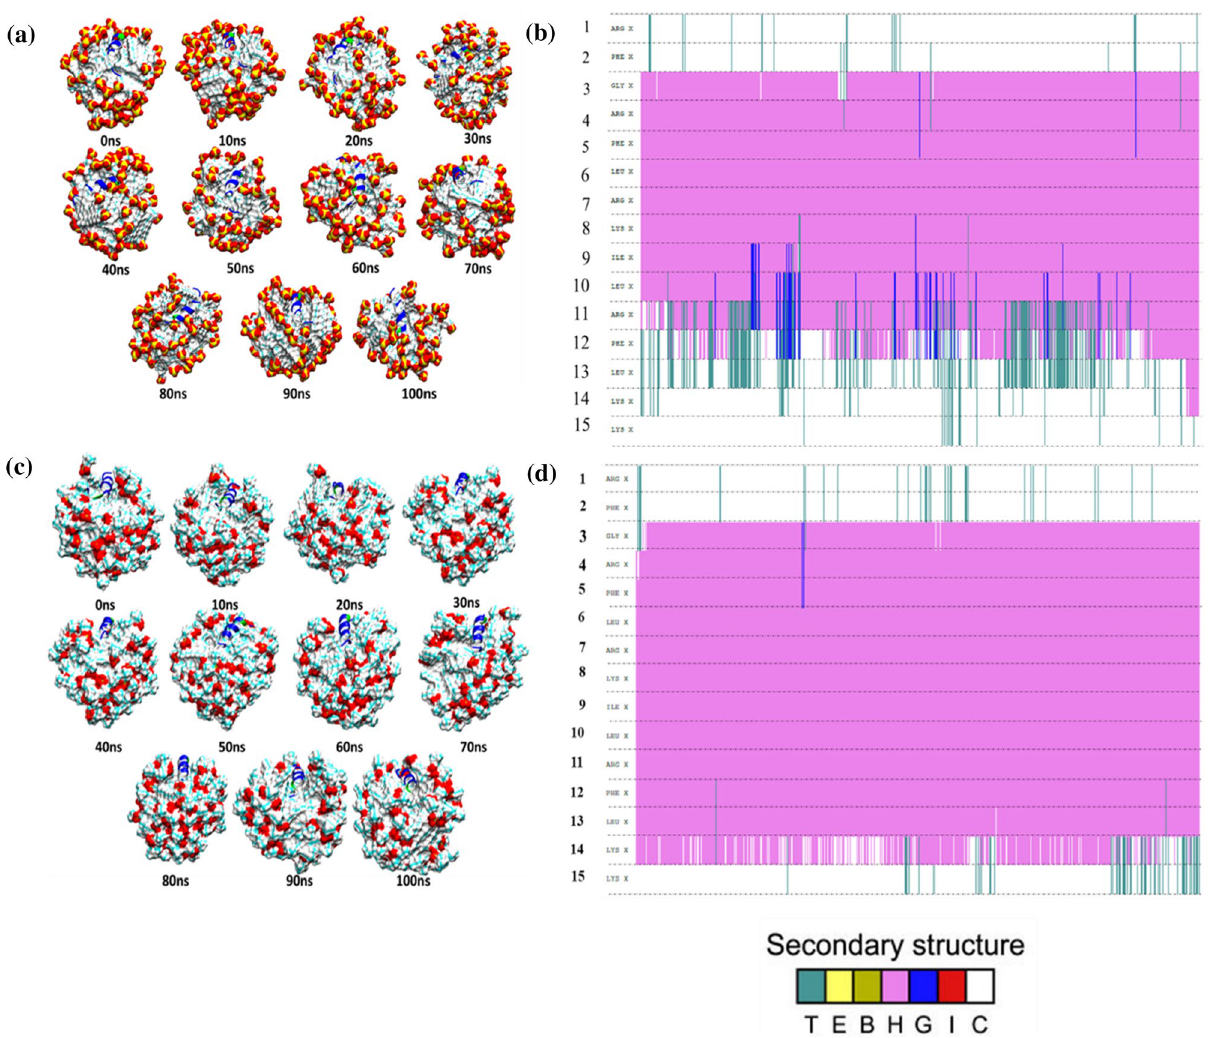
Figure 3. Selected snapshots of the SDS micelle with peptide ( a ) and DPC micelle with peptide complex ( c ). The secondary structure analysis of the peptide in SDS micelle ( b ) and peptide in DPC micelle with water complex ( d ) throughout the 100 ns trajectory. y-axis represents the amino acid sequence of DP1 and the colored area represents the secondary structure it adopts. (Turn, T (green); helix, H (pink); 310 helix, G